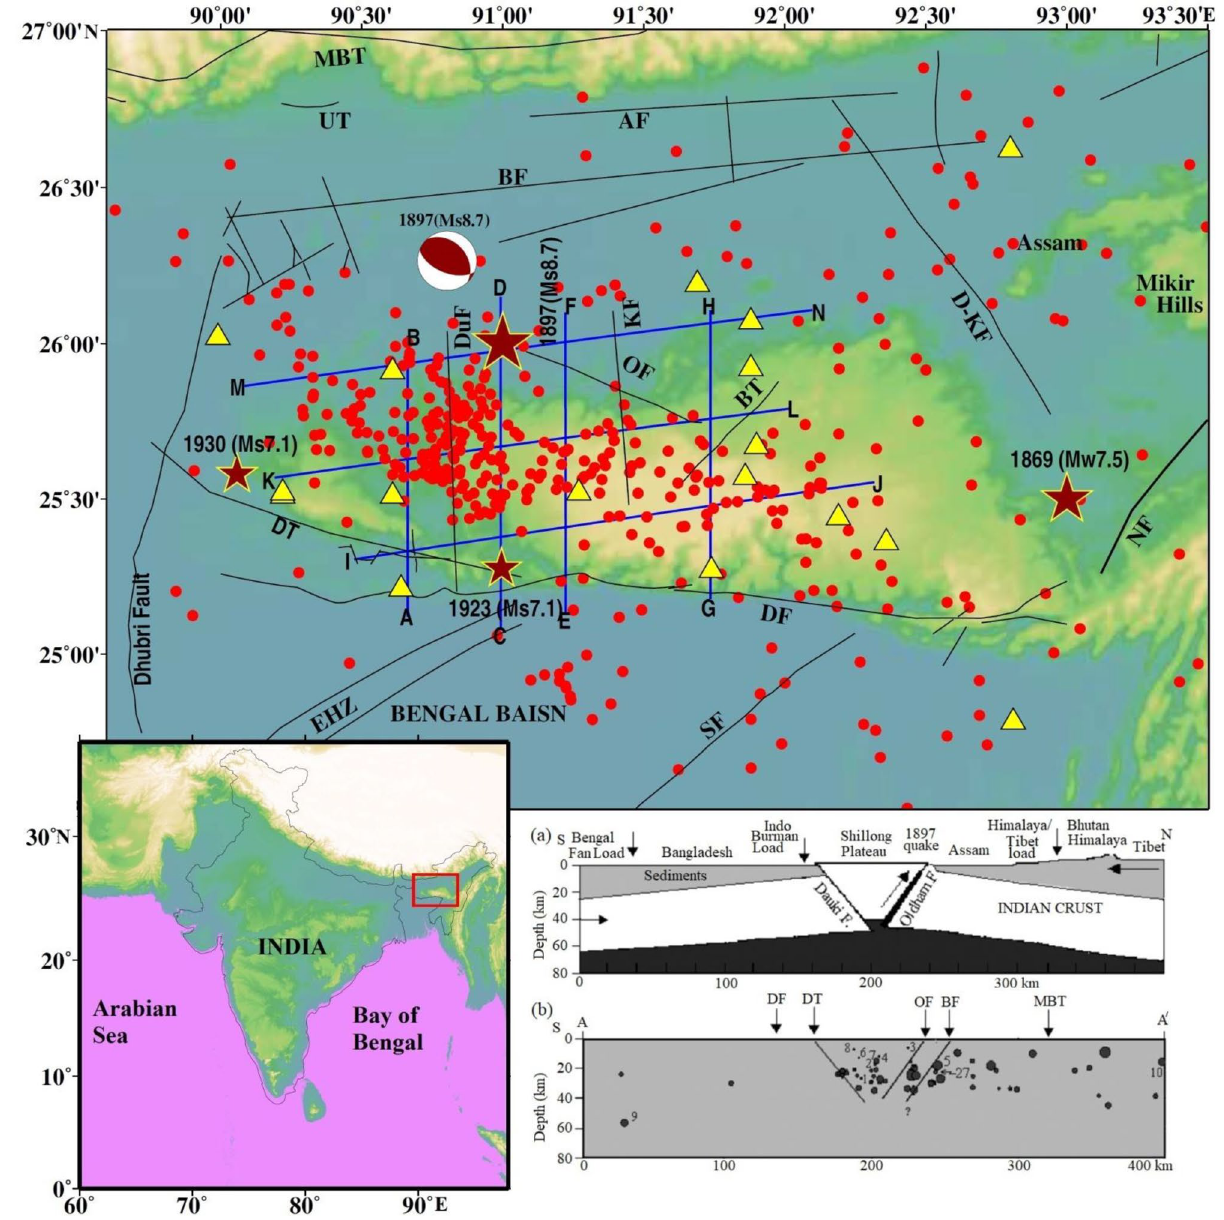
Figure 1. Topographic map of the Shillong Plateau showing major earthquakes (stars) M ≥ 7.0 including an 1897 great (M s 8.7) earthquake. The focal mechanism of the 1897 earthquake is shown. The major tectonic features are also shown, such as DF: Dauki Fault; DT: Dapsi Thrust; OF: Oldham Fault; DuF: Dudhani Fault; KF: Kulsi Fault; BT: Barapani Thrust; BF: Brahmaputra Fault; NF: Naga Fault; D-KF: Dhansiri–Kopili Fault; SF: Sylhet Fault; UT: Ultapani Thrust; AF: Atherkhet Fault; EHZ: Eocene Hinge Zone and MBT: Main Boundary Thrust. The tectonic features are taken from the Geological Society of India, http:// bhuko sh. gsi. gov. in/ Bhuko sh/ Public and from published literature. Triangles show the seismic station while red solid circles show the seismicity, used in the present study. Inset the location of the Shillong in the map of India (left panel) while right panel shows N–S section from Tibet to the Bay of Bengal showing the geometry of the plateau pop-up tectonic models proposed by ( a ) Bilham and England (2001) and ( b ) Kayal et al.